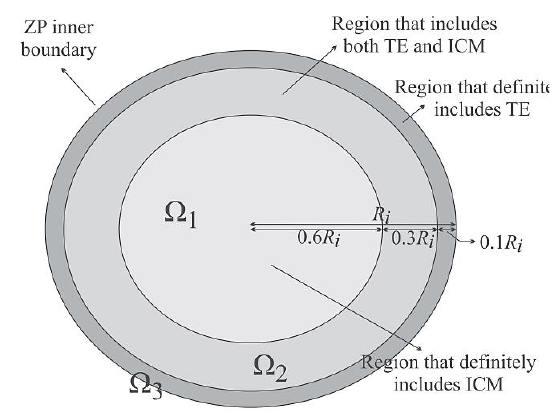
Figure 5. Biological characteristics of blastocyst cellular feature map and its component [67].